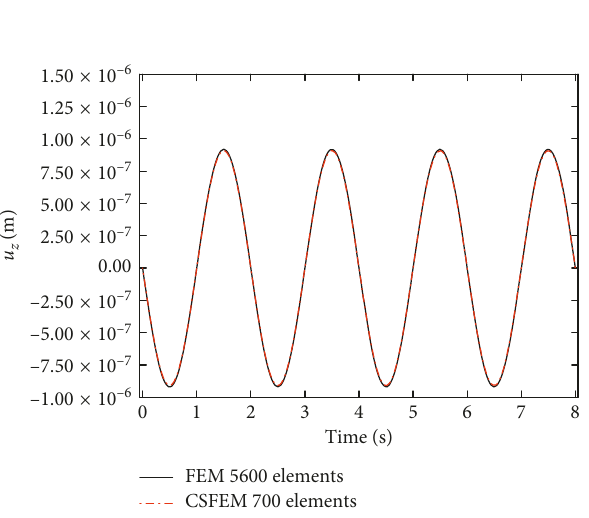
Figure 26: The variation of the displacement u x of the PCMs harvester at point A with respect to time.